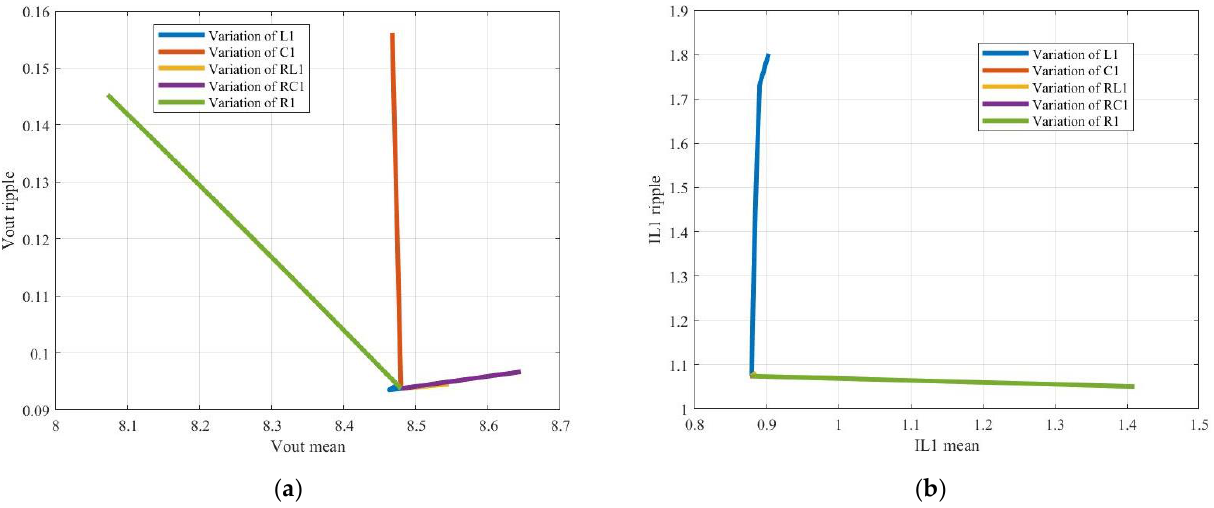
Figure 11. Testability assessment for a boost converter during the switch-on period: ( a ) measurement of output voltage; ( b ) measurement of inductor current.